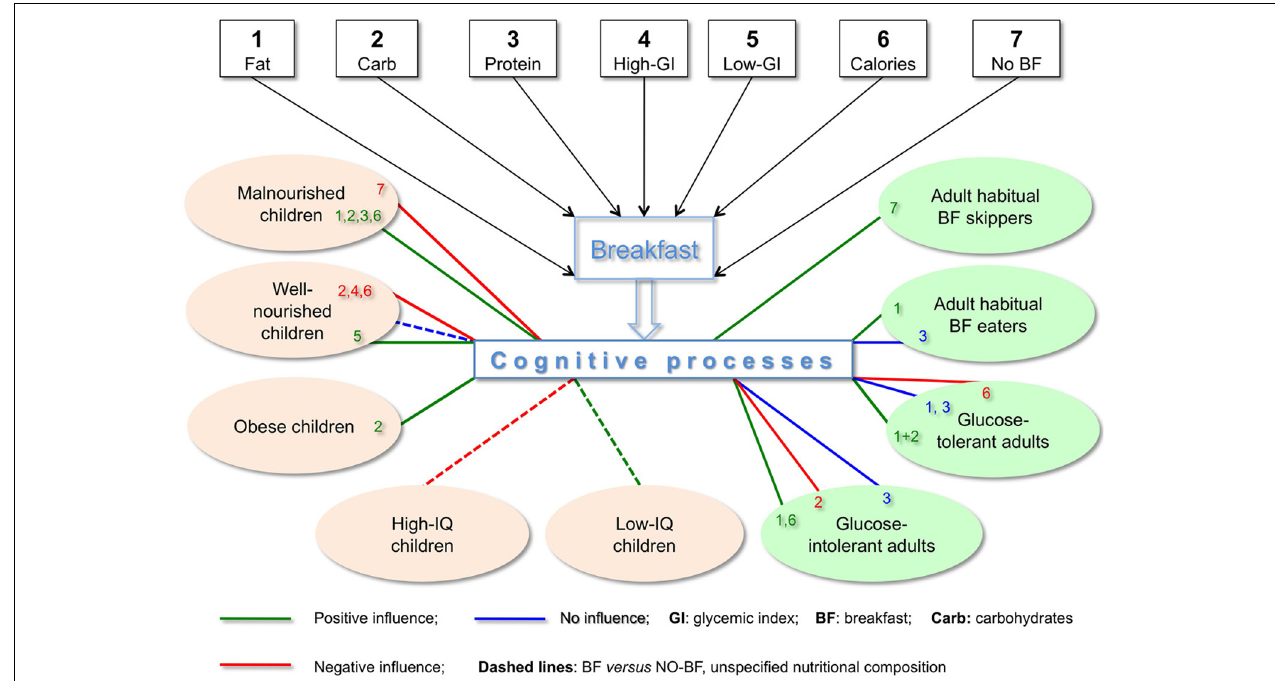
FIGURE 1 | Cognitive effects depend on nutritional composition of breakfast and characteristics of subjects. Effects on cognition in children depend on BF composition (macronutrients, GI, calories), nourishment (malnourished, well-nourished, obese) andIQ.Inadults,cognitiveeffectsofBF also depend on BF composition as well as on glucose tolerance and whether